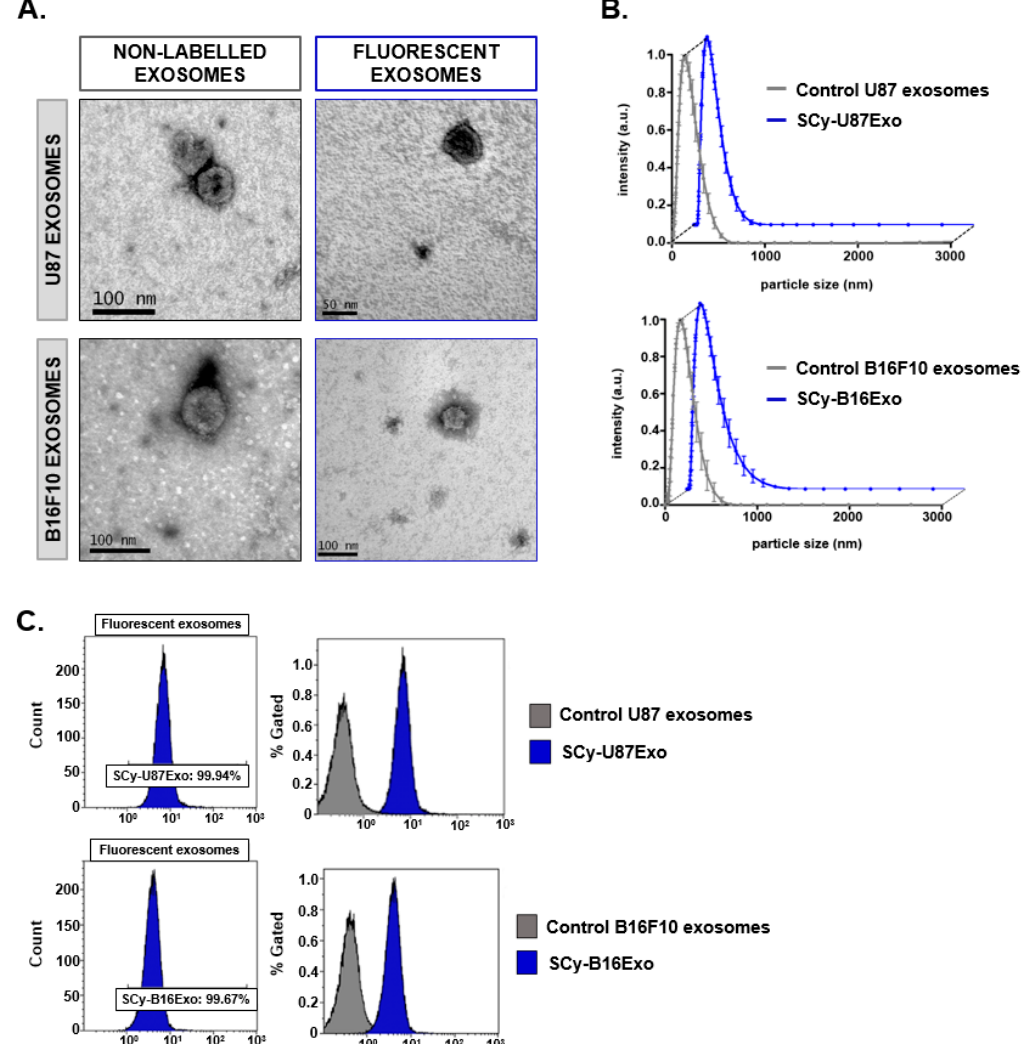
Figure 2. Physicochemical characterization of control and fluorescence-labeled cancer cell line-derived exosomes. ( A ) Transmission electron microscope images show the nanovesicle morphology. ( B ) Size distributions of exosomes produced with dynamic light scattering. Data are expressed as the mean ± standard deviation. ( C ) Flow cytometry results show abundances of control exosomes and the fluorescent nano-probes. SCy: sulfo-cyanine 7.5; U87Exo: exosomes derived from U87 glioblastoma cells; B16Exo: exosomes derived from B16F10 mouse melanoma cells .